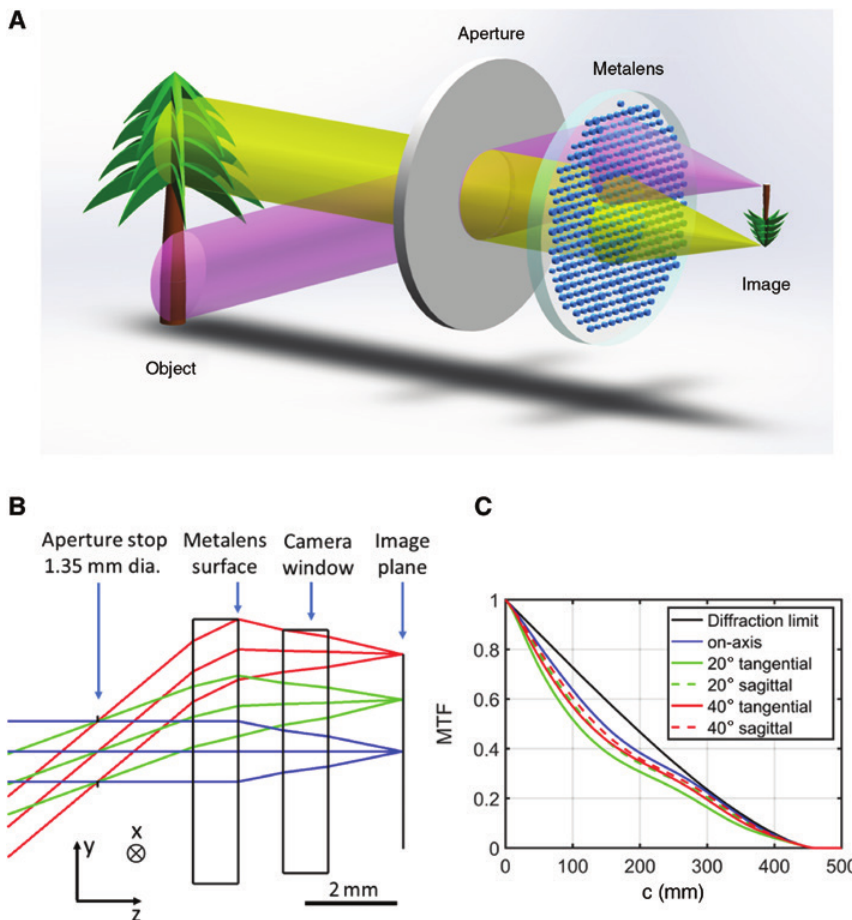
Figure 1: Metalens optical layout and performance. (A) Schematic illustration of imaging with Huygens metalens. (B) Optical layout. Ray fans drawn are for 0 ° , 20 ° , and 40 ° incidence. (C) Nominal MTF for monochromatic 850-nm